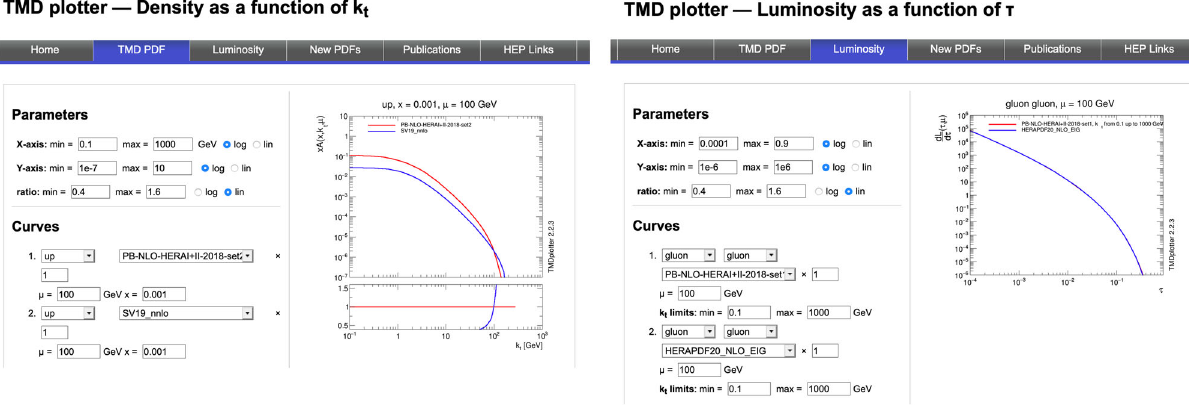
Fig. 3 TMDplotter examples: (left) comparison of the transverse momentum distributions of different TMD sets, (right) gluon-gluon luminosity calculation using integrated TMD sets (the curves from PB-NLO-HERAI+II-2018-set1 and HERAPDF2.0